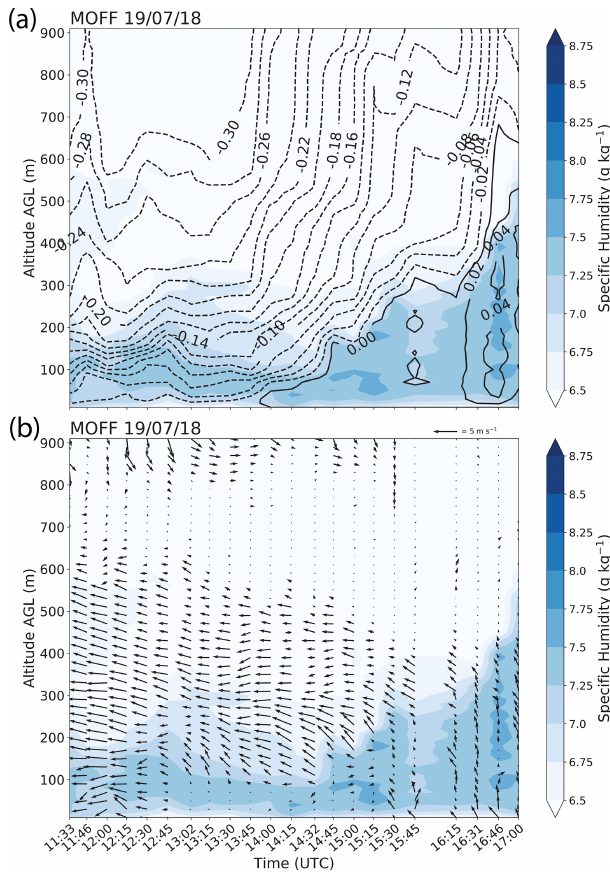
Figure 9. (a) Buoyancy contours (ms − 2 ), where solid (dashed) lines are positive (negative) and filled contours are specific humid- ity (gkg − 1 ). (b) Wind vectors over specific humidity (gkg − 1 ), with filled contours from CopterSonde measurements on 19 July 2018 at